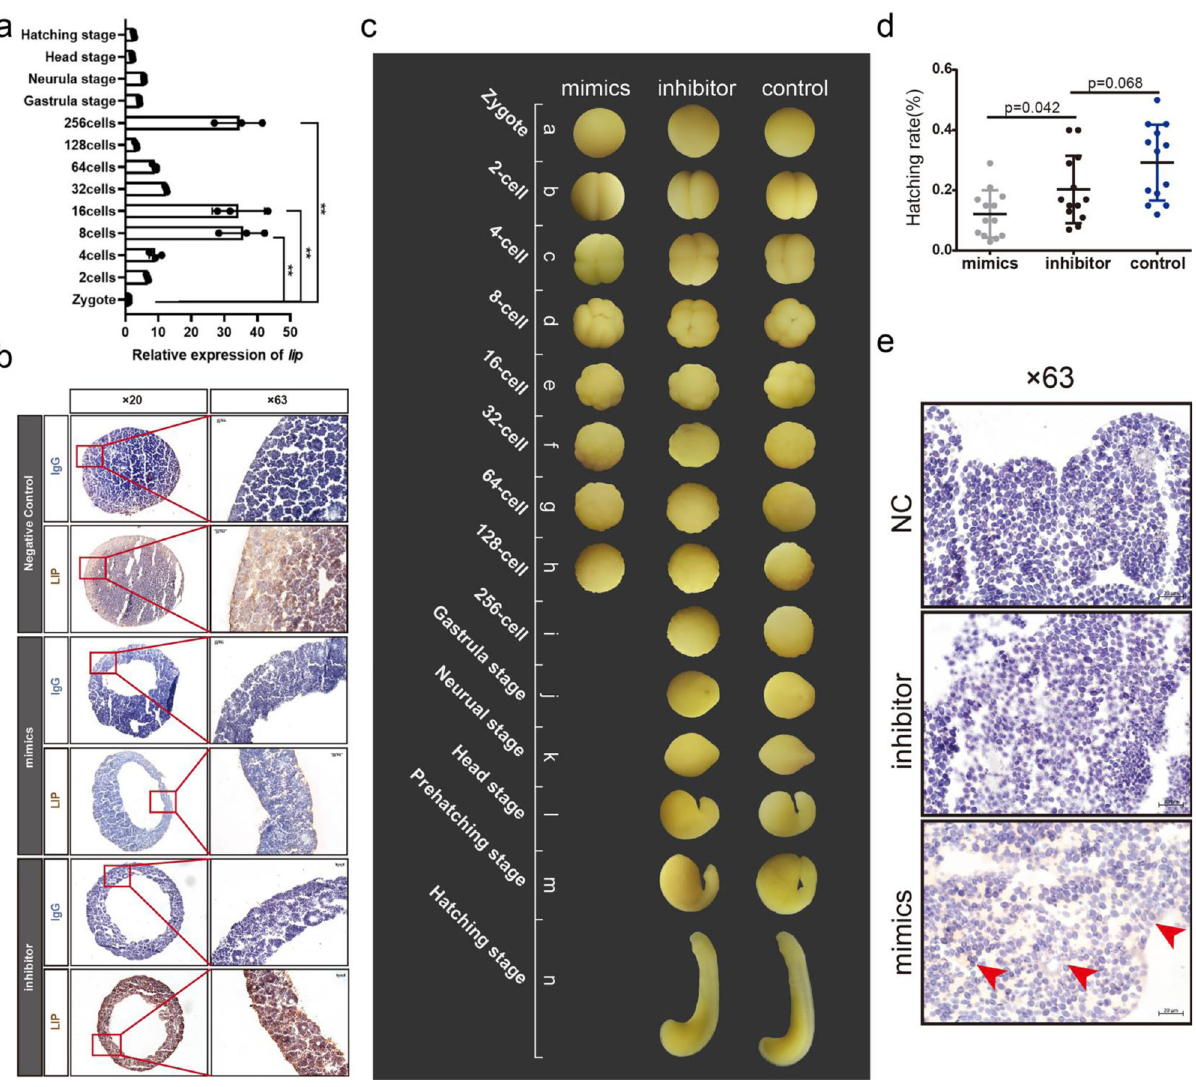
Fig. 7 miR-4561 regulates LIP expression and survival rate in lamprey embryos. a LIP mRNA expression level in normal lampreys at the indicated embryonic stage (** P < 0.01). b LIP protein staining using IHC of 256-cell stage embryos after microinjection of miR-4561 mimics, inhibitor, and NC. c Growth and development pattern of embryos after microinjection. d Survival rate of lamprey larvae recorded 11 d post-fertilization and hatching rate of lamprey embryos injected with miR-4561 mimics, inhibitor, and NC. e TUNEL staining of 128-cell stage embryos injected with miR-4561 mimics, inhibitor, and NC. The red arrow indicates the apoptotic